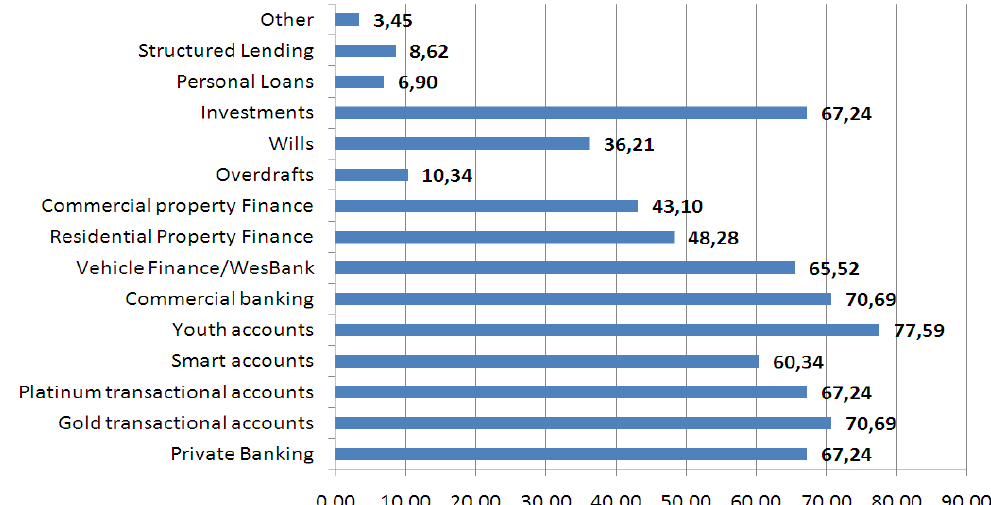
Fig. 3. Which of the following products does FNB Islamic banking